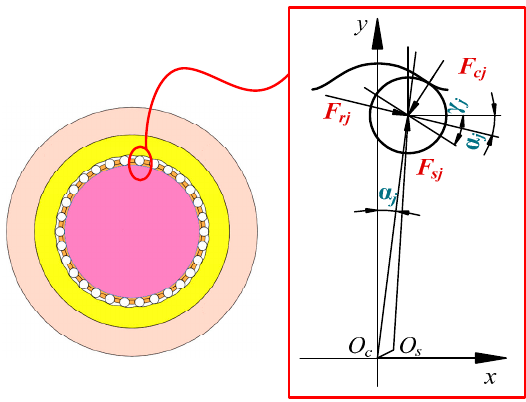
Figure 6. Forces of a selected single movable tooth.